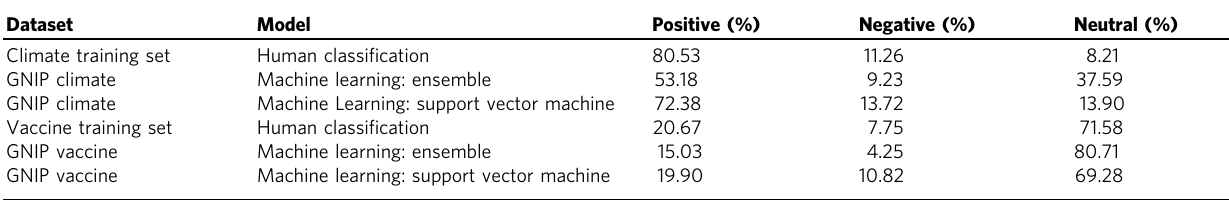
Table 2 Sentiment of tweets varies between climate change and vaccine discussions.